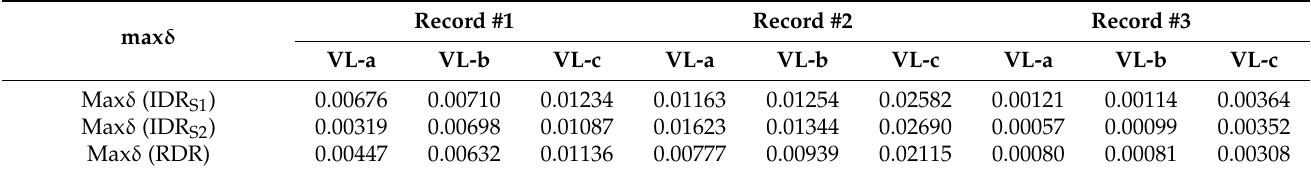
Table 7. Maximum values of the geometrical distance between the EDPs calculated over each time history with and without the vertical